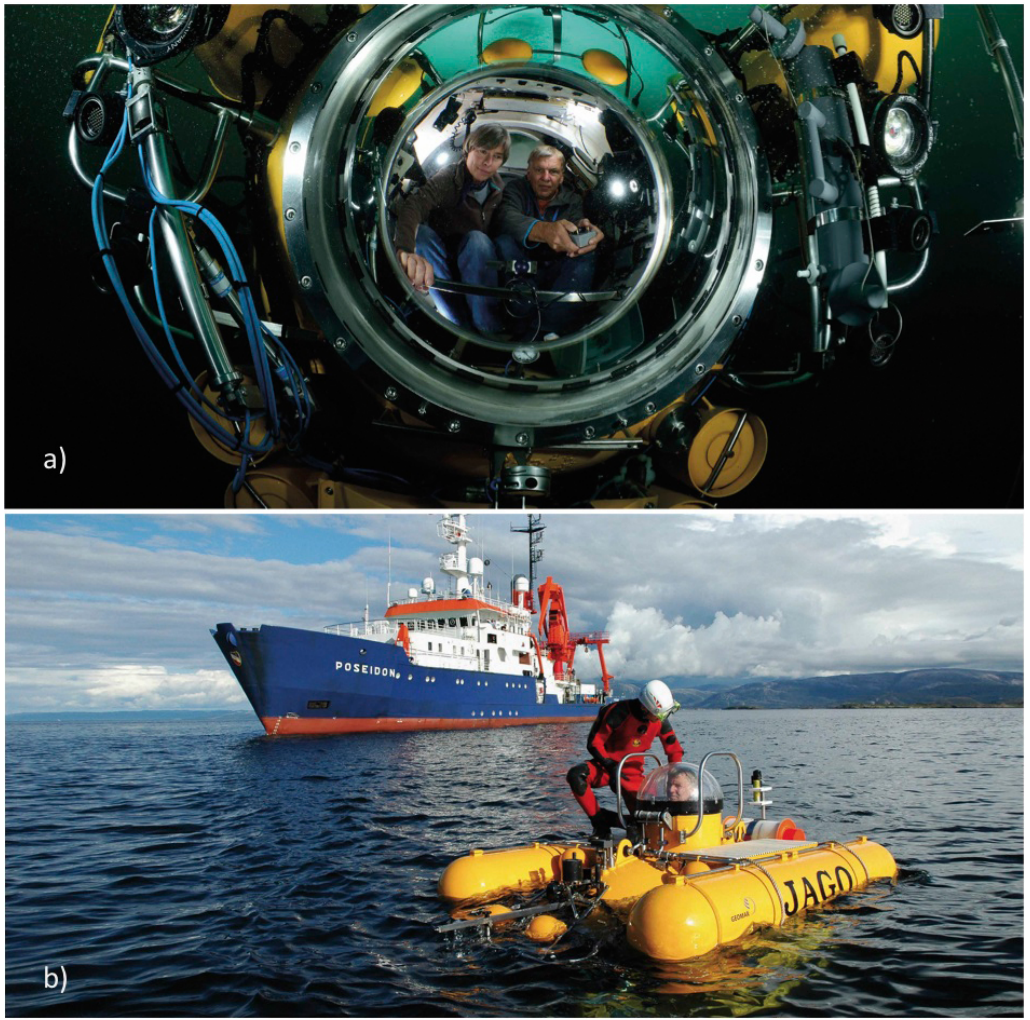
Figure 2: Manned submersible “JAGO”, a) view from outside through the front window into the person- nel cabin, b) at the sea surface after deployment from on board the German research vessel “POSEIDON” in the Trondheim Fjord